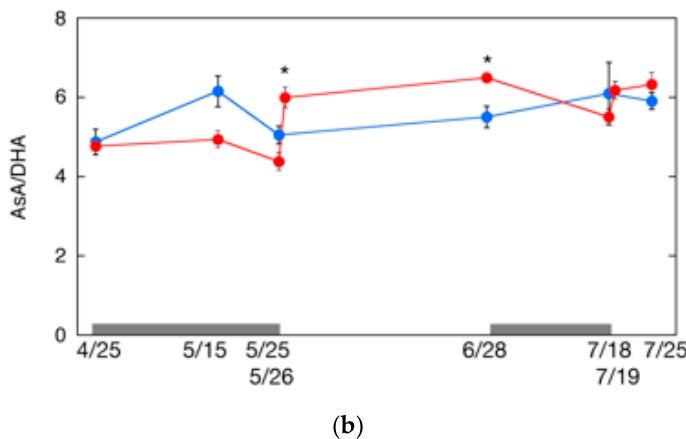
Figure 5. Changes in AsA content in shaded tea leaves after shade removal. ( a ) Total AsA content and ( b ) the ratio of AsA to DHA are shown. Gray bars indicate the period of shading treatments. Data are shown as means ± standard deviation ( n = 3). Statistical analysis was performed as described in Figure 3. Asterisks indicate significant differences ( p <